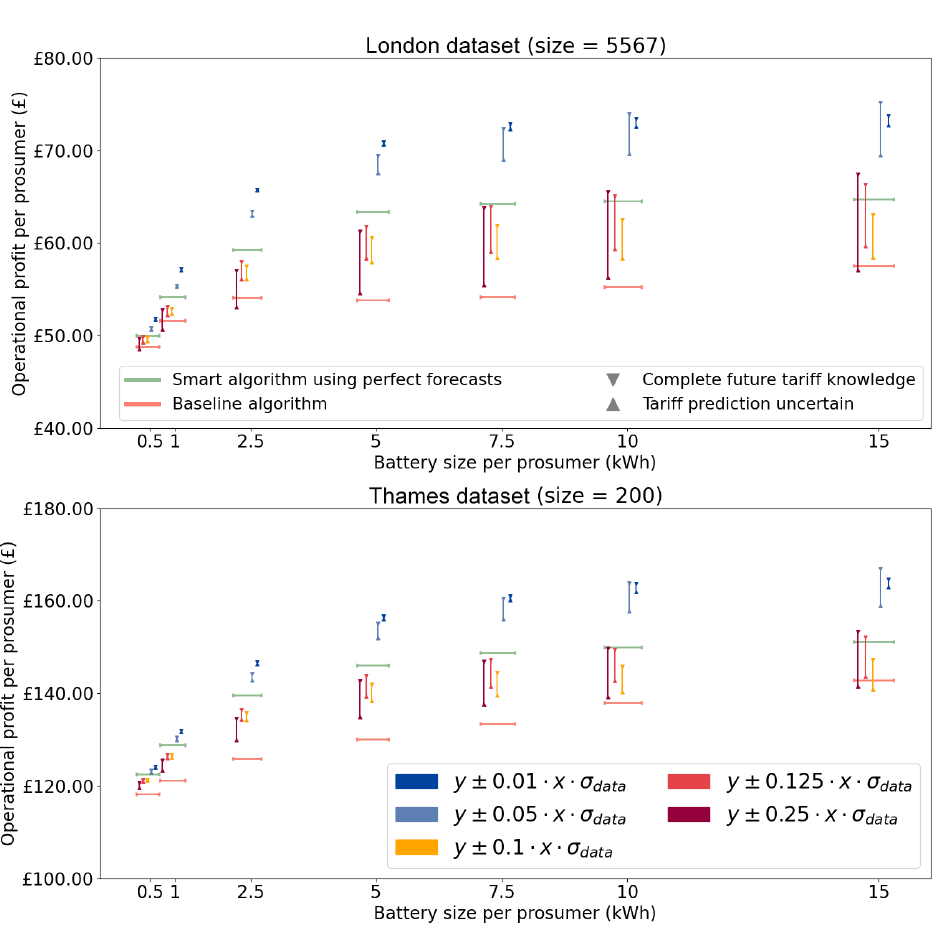
Figure 12. High-level comparison between operational profits of the baseline algorithm and smart al- gorithm for the average prosumer using various battery sizes and lookahead amounts with uncertain forecasts based on linear margins. The legend in each graph applies to both graphs.